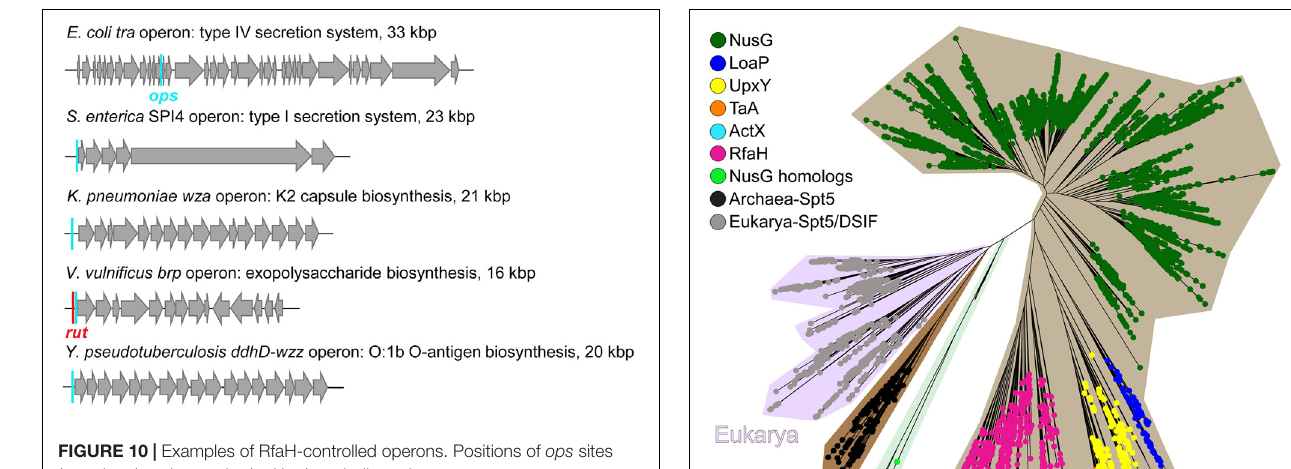
DIVERSITY OF THE NusG